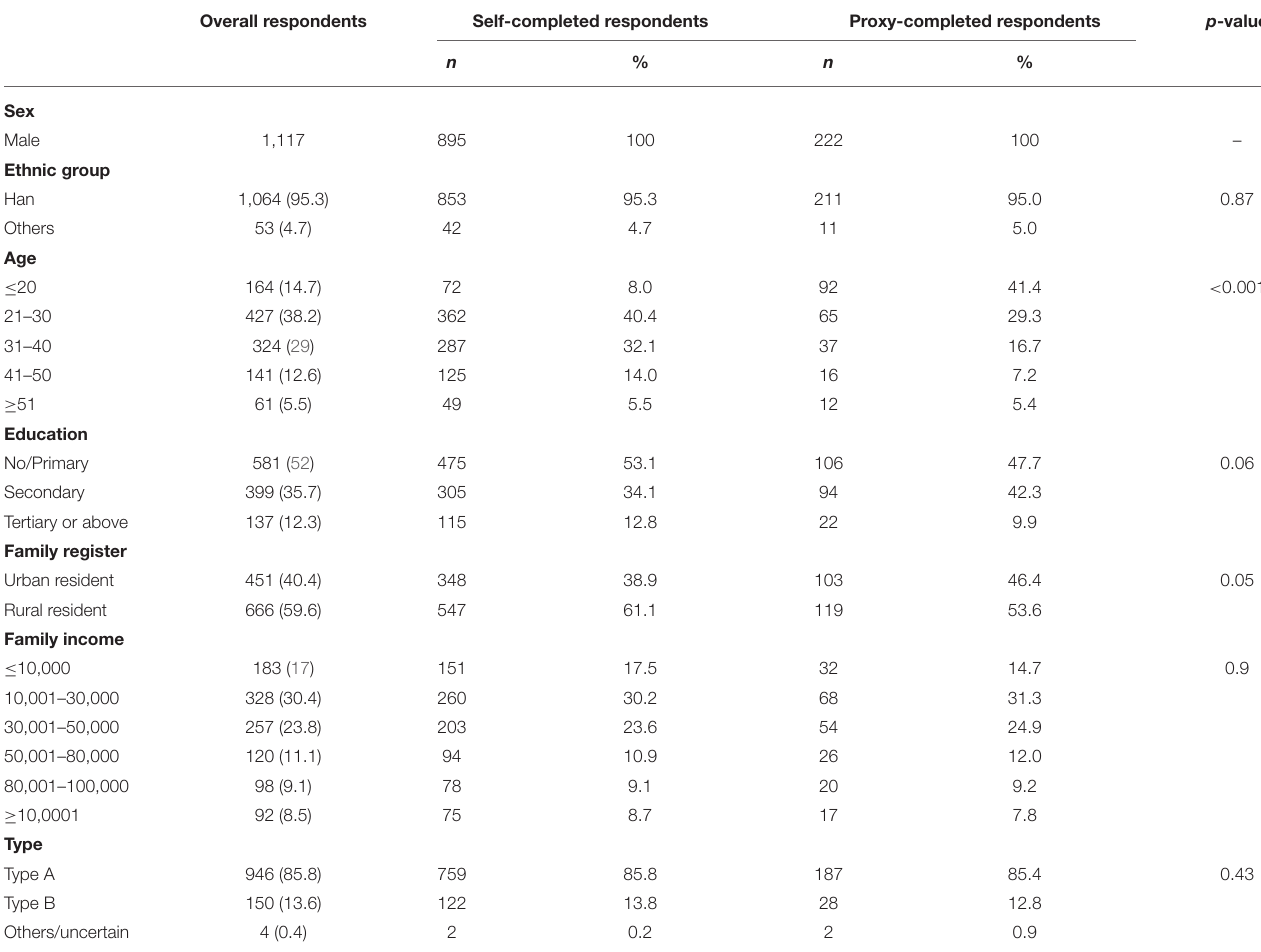
TABLE 1 | Respondents’